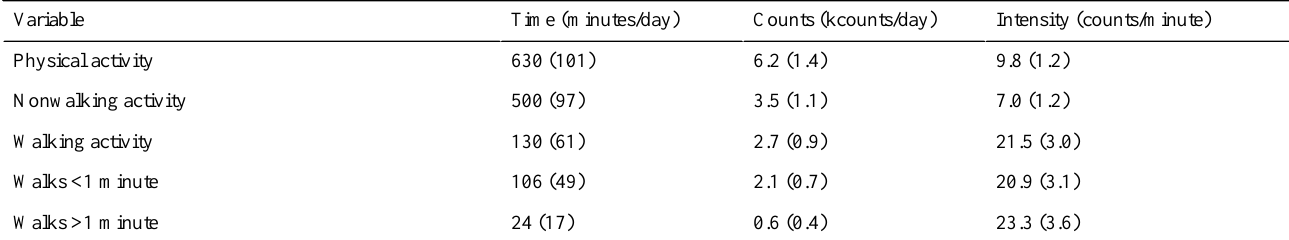
Table 2. Physical activity and walking activity (N=42); mean (SD).